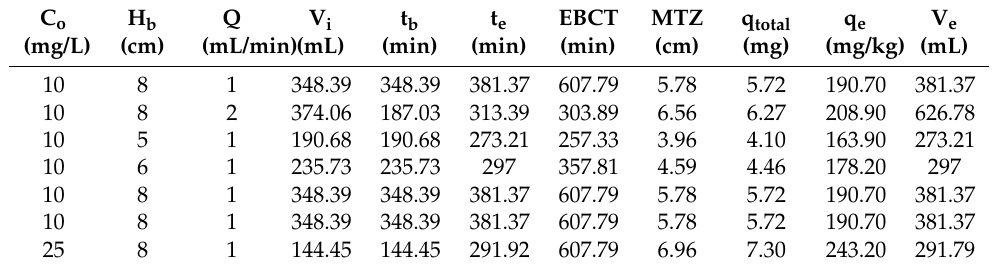
Figure 3. Effect of adsorbent bed height on phosphate breakthrough. Table 1. Obtained parameters from breakthrough curves for phosphate adsorption onto leftover coal material with different bed heights, initial phosphate concentrations, and flow